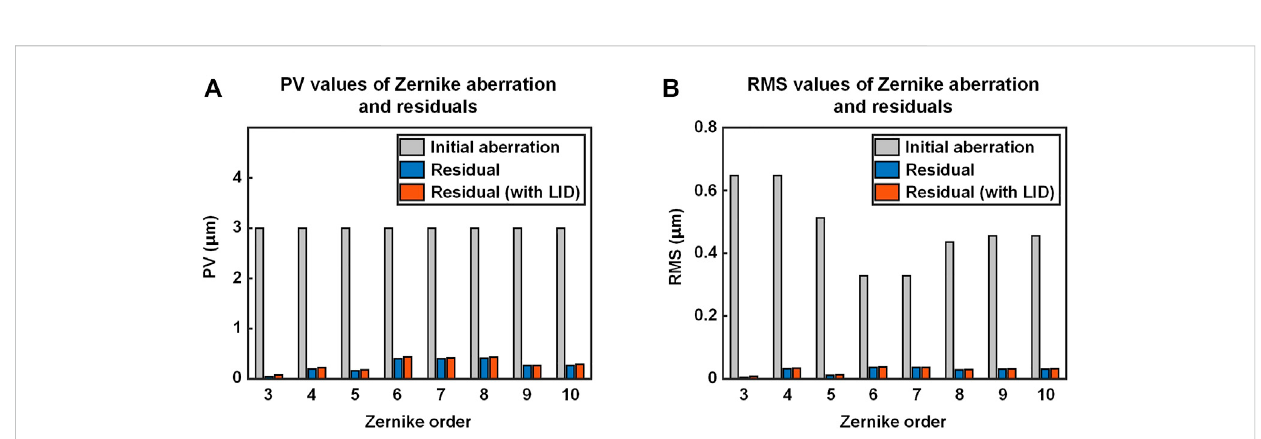
FIGURE 12 Zernike mode aberrationscorrection results of the lab-manufactured DDM. The correction results of original Zernike mode aberrations are marked in blue. The correction results of Zernike mode aberrations superimposed with the LID are marked in orange. (A) PV values. (B) RMS